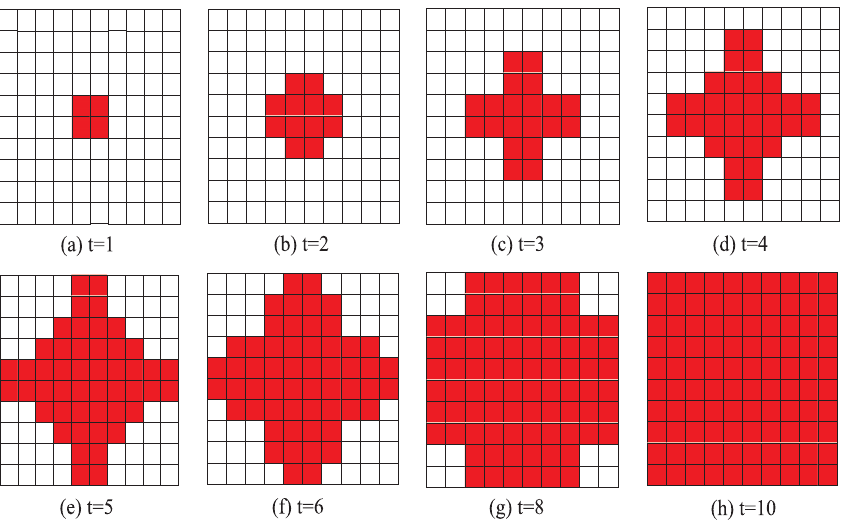
Figure 6. (Color online) Time evolution of cooperator-invasion on a 10 | 10 square lattice with 4-player neighborhood. Initially, there are four cooperators who select strategy M (the four red squares in figure (a)) and ninety-six defectors who choose strategy R (the ninety-six blank squares in figure (a)). If R v 2 M = 5 , then the cooperators occupy all the squares in the stationary state ( t ~ 10 , figure(h)).